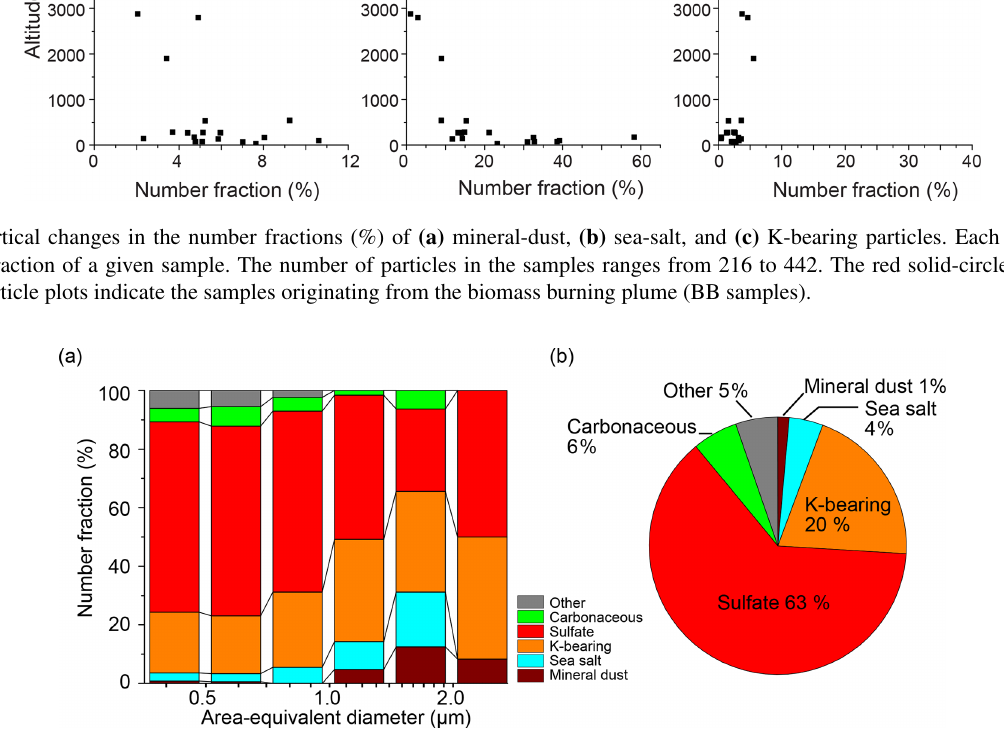
Figure 5. Number fractions of the aerosol particles in the BB samples. (a) Size-dependent and (b) total number fractions. Three BB samples were collected on 2, 3, and 4 April. The size bins are shown on a log scale and are 0.35–0.5, 0.5–0.71, 0.71–1.00, 1.00–1.41, 1.41–2.00, and > 2.00µm. (b) Number fractions of the total particles of the BB samples. The particle number of the BB samples is